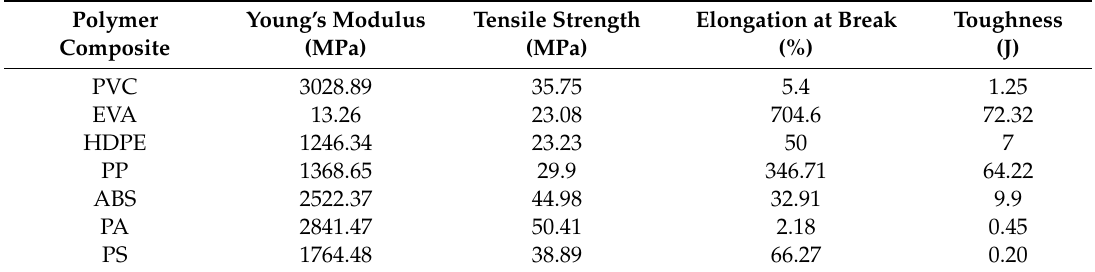
Table 4. Values of each neat polymers mechanical properties analyzed without GTR